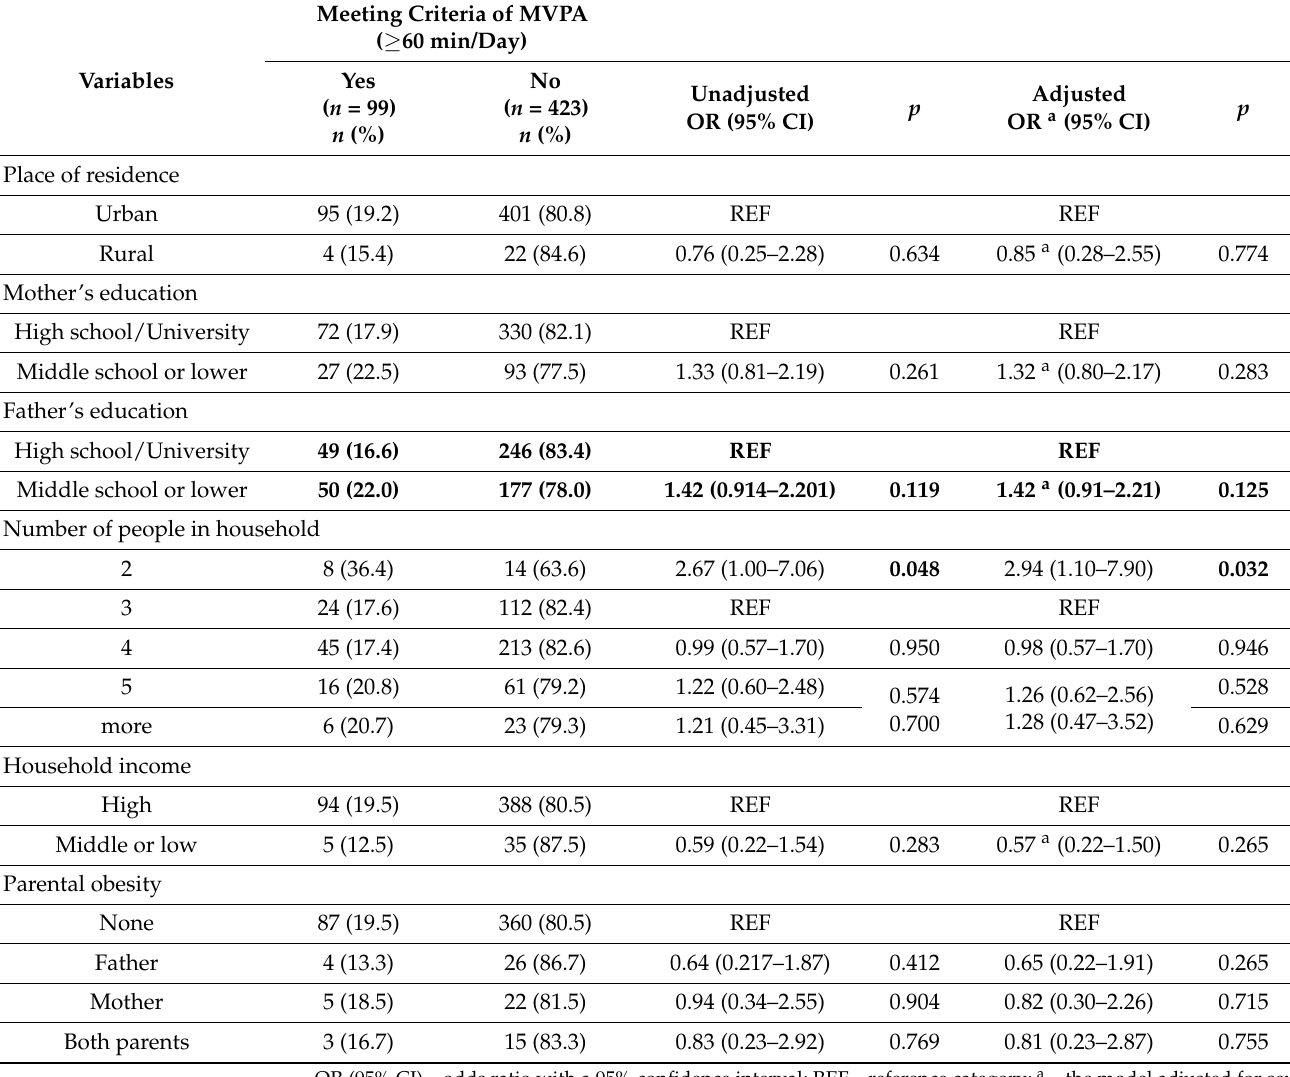
Table 5. Linking MVPA criterion fulfilment parameters ( ≥ 60 min/day) to socioeconomic factors.